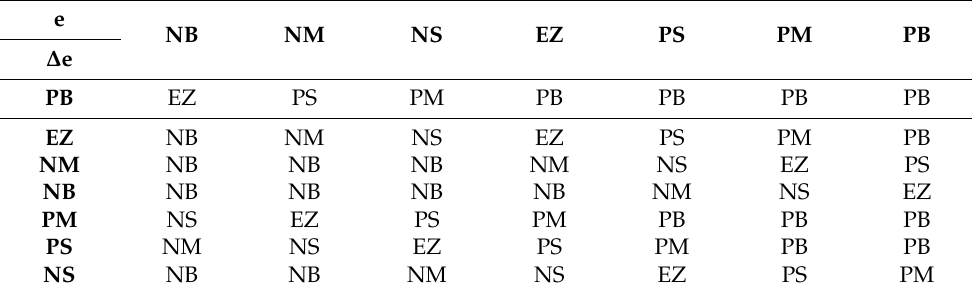
Figure A2. Structure of the FLC. Table A2. Fuzzy rules of the hysteresis comparators.